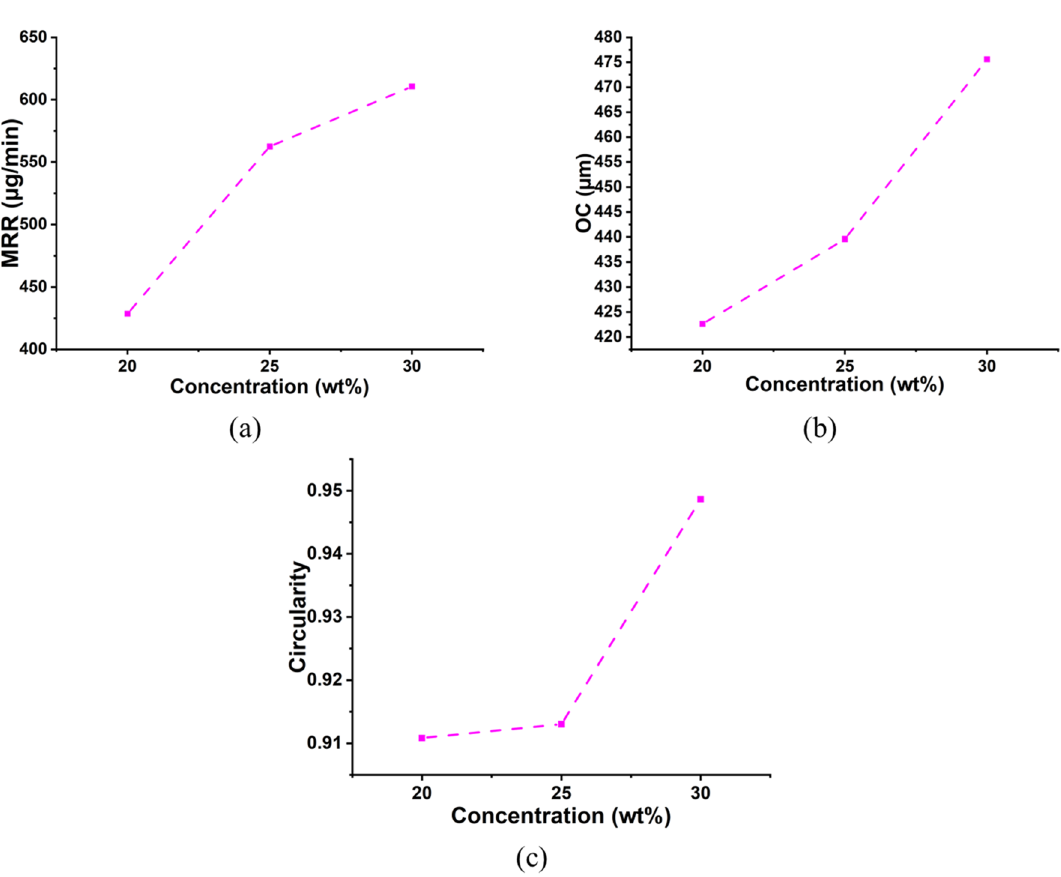
Figure 8. Influence of electrolyte concentration on machining characteristics ( a ) MRR, ( b ) OC, and ( c )